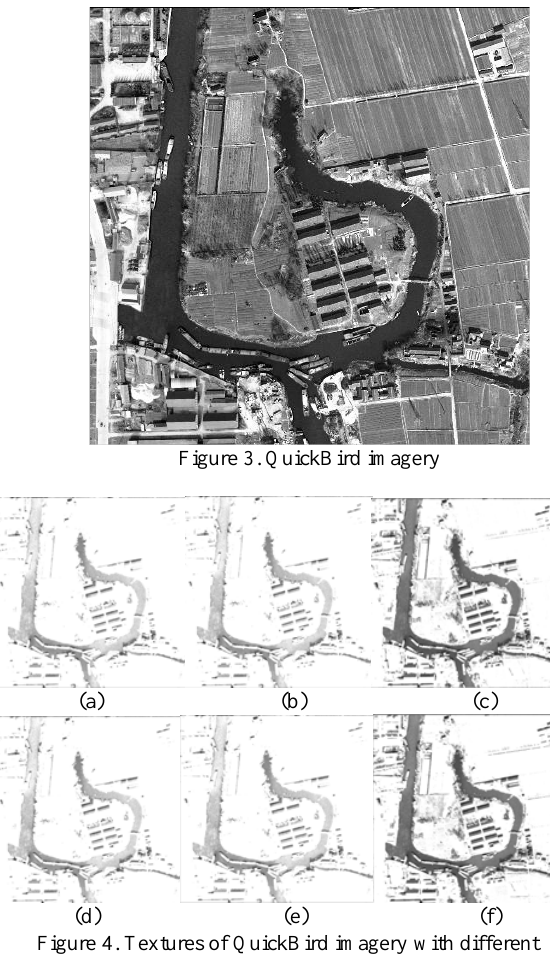
πθ= to πθ= 6 π with every 6